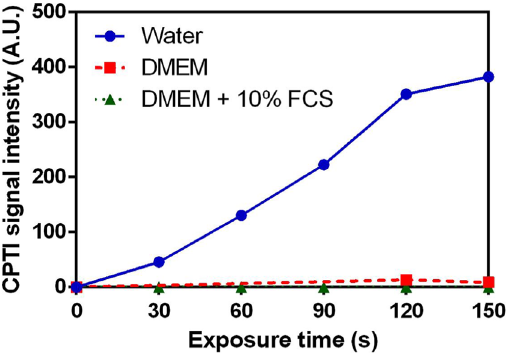
Figure 8. Variation of the concentration of C-PTIin water, DMEM + / − 10% FCS after He plasma treatment at various exposure time.